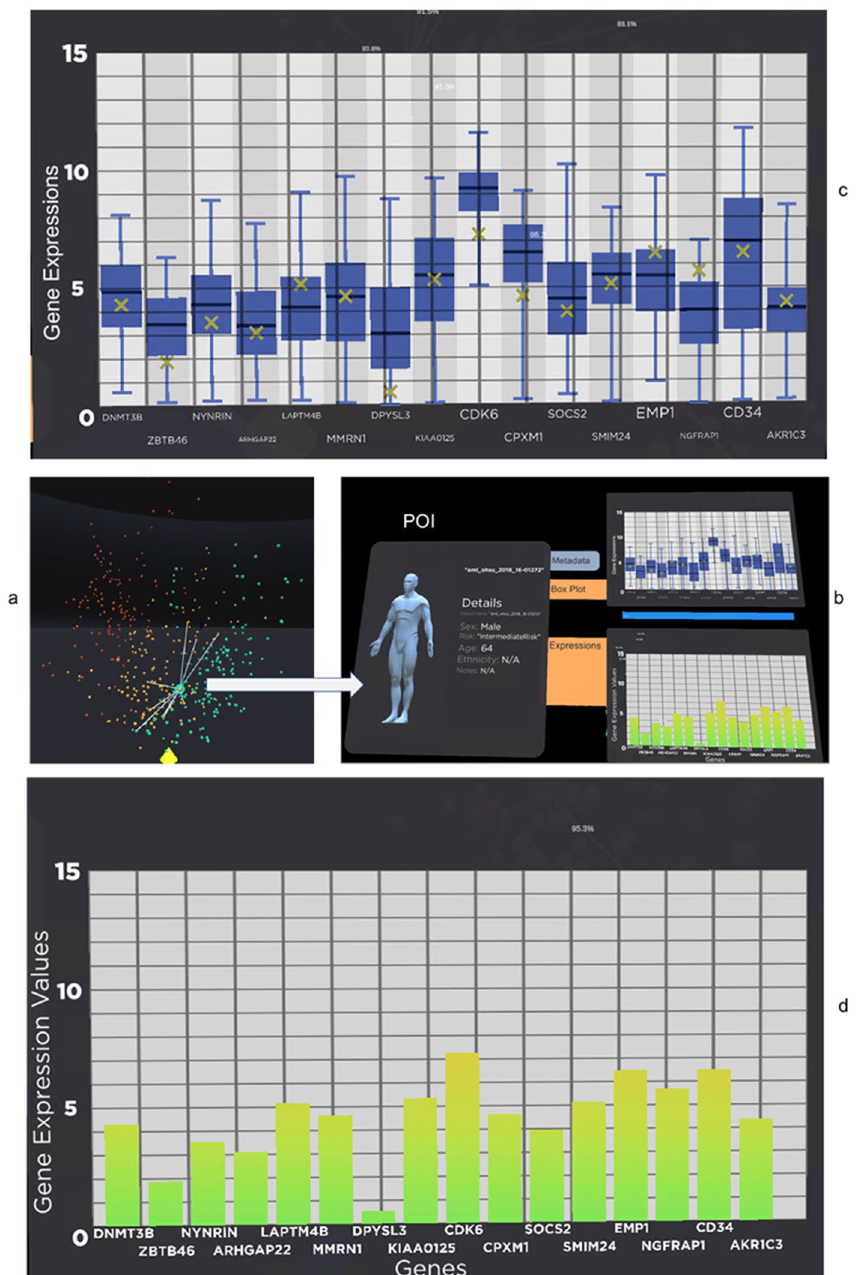
Figure 3. Patient "aml_ohsu_2018_16-01272" is selected from ( a ) and drag into ( b ) patient of Interest panel. The panel shows the metadata for the patient, such as age, gender and ethnicity. ( c ) The tablet also contains the box plot of the patient gene data compared to the whole population. The patient gene expression value is clearly marked as an "x" (yellow) in the box plot. ( d ) A bar chart of the gene expression